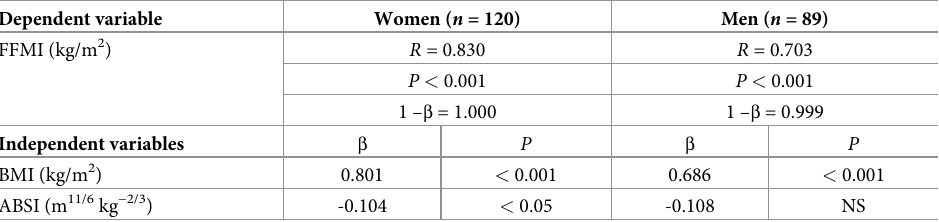
Fig 1. Correlations of fat-free mass index (FFMI) with body mass index (BMI) (A) and with a body shape index (ABSI) (B) in women ( � ) and men (•). See Table 4 for Spearman’s rank correlations and Table 5 for results of multiple regression analysis with FFMI as dependent variable and BMI and ABSI as independent variable.